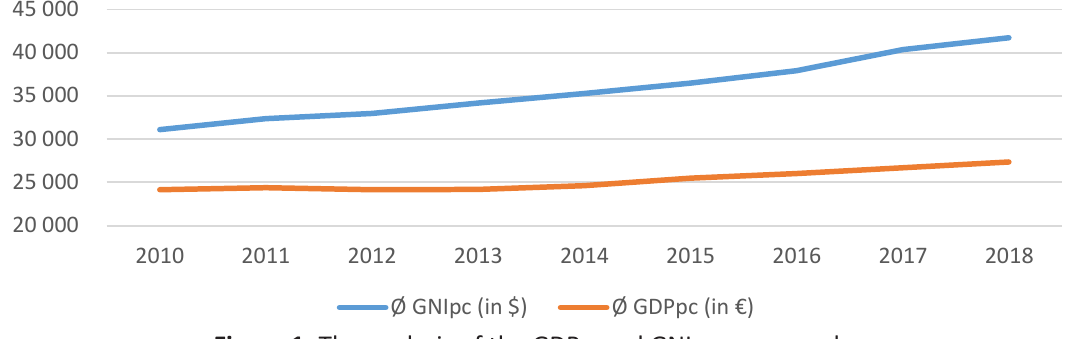
Figure 1. The analysis of the GDP development in the EU (28)